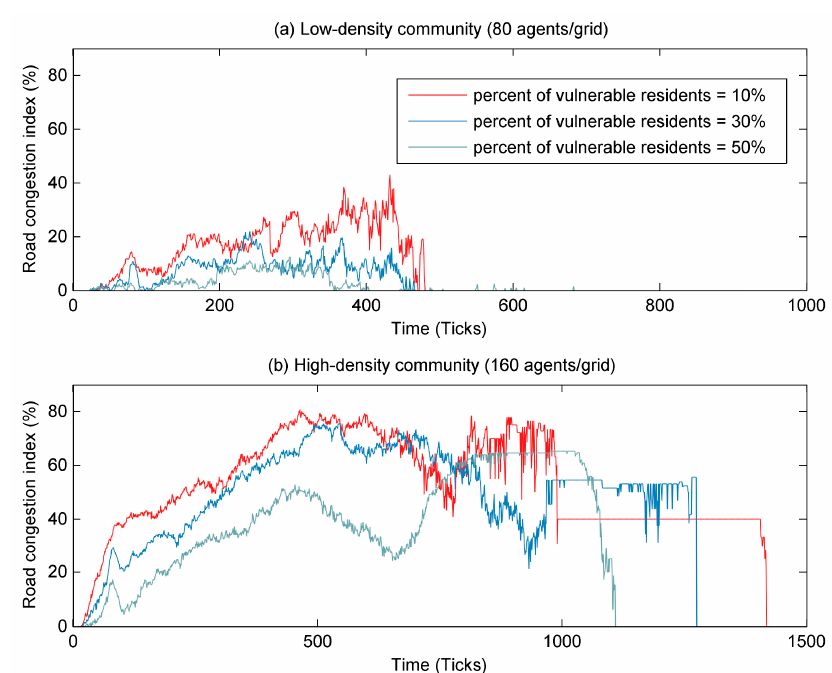
Figure 9. The changes in road congestion index with time in different communities. The percent of vulnerable resident agents was set as 10%, 30% and 50%. ( a ) The road congestion index in a low-density community (80 agents / grid); ( b ) The road congestion index in a high-density community (160 agents / grid).